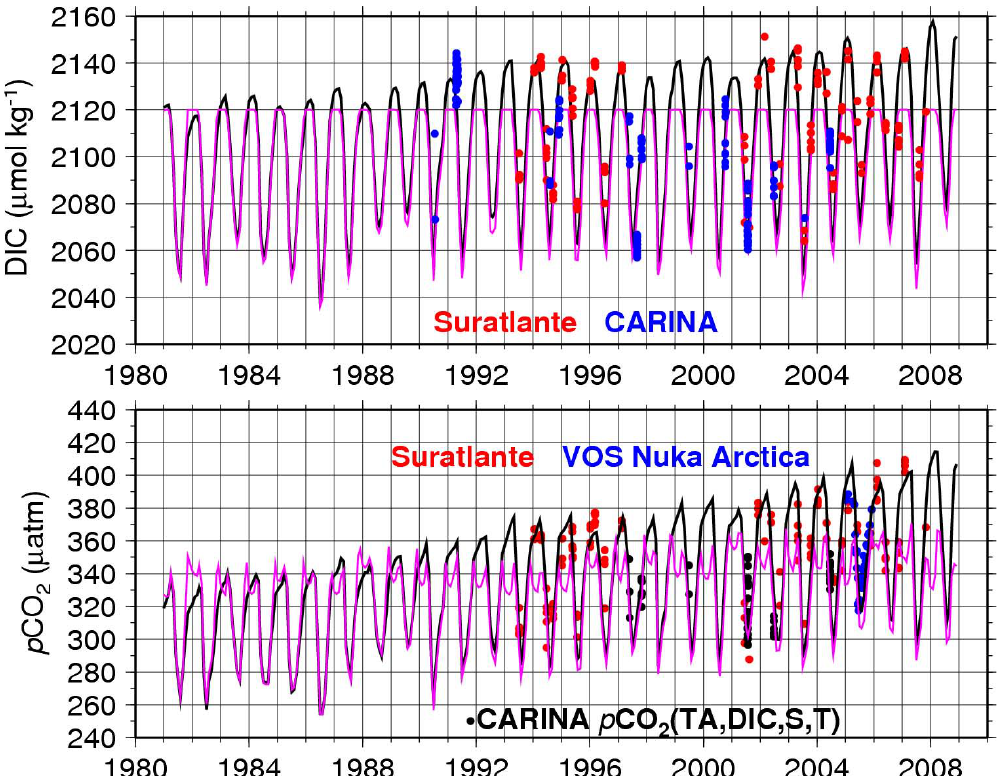
Fig. 7b. Time series of surface DIC (top) and ocean p CO 2 (bottom) from two model experiments, one including deep water DIC and TA relaxation and bottom DIC trend (Experiment A, black lines) and one without it (Experiment B, purple lines). The red, blue and black circles represent the available data for